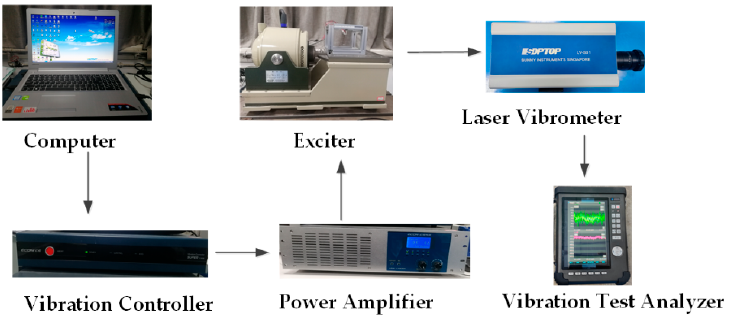
Figure 9. Experimental platform.